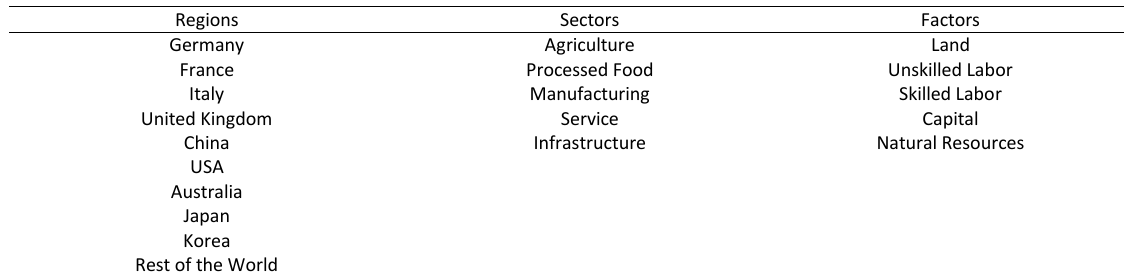
Table 1: Aggregation used in the model Regions Factors